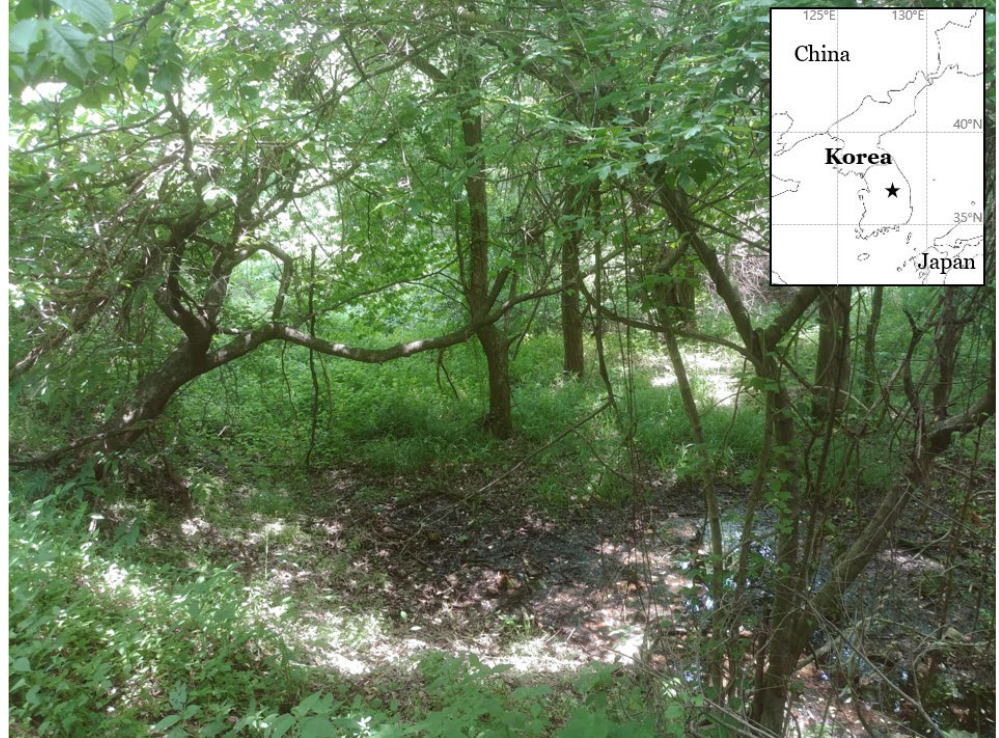
Figure 1. Specific collection site for the new species Psoroglaena humidosilvae (black star mark). The small swamp is located below a forest road and comprised mainly of Salix koreensis Andersson, Alnus incana (L.) Moench subsp. hirsuta (Turcz. ex Spach) Á .Löve and D.Löve, Fraxinus sieboldiana Blume and Weigela subsessilis (Nakai) L.H.Bailey. Lichens were detected on the barks of Salix koreensis and Alnus incana subsp. hirsuta .